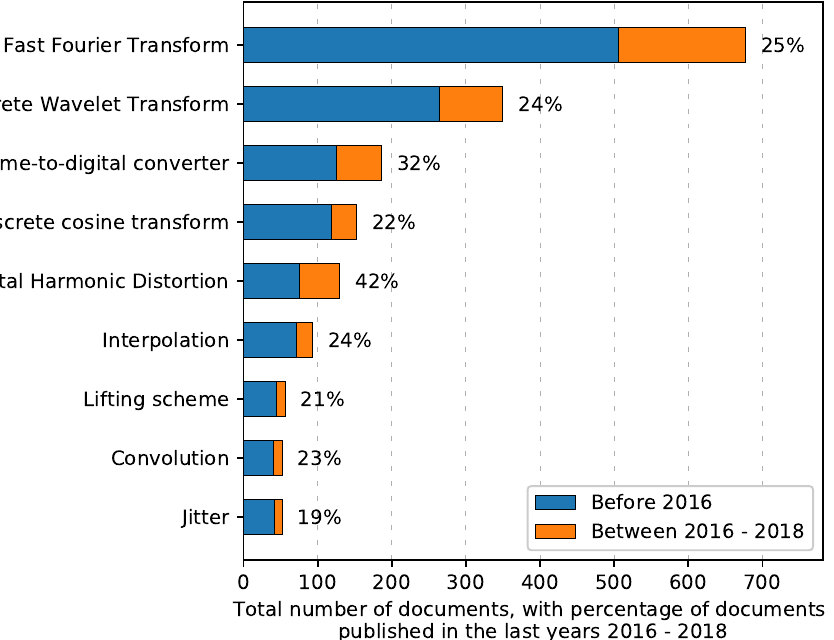
Figure 10. Digital signal processing top implementations in FPGA